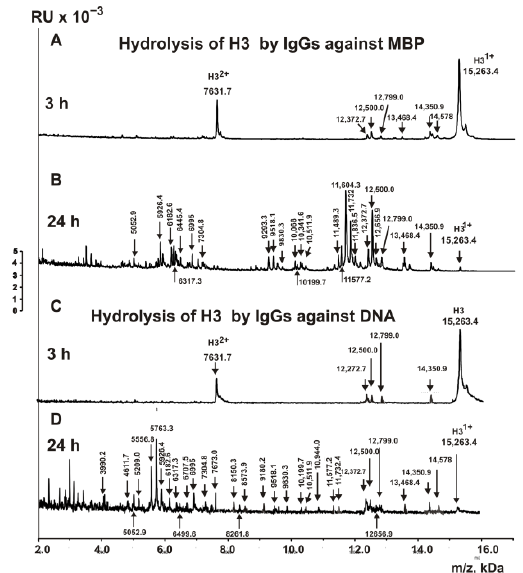
Figure 3. MALDI spectra corresponding to the H3 histone (0.8 mg/mL) over the time of hydrolysis in the presence of IgGs (0.04 mg/mL) against MBP ( A , B ) and DNA ( C , D ). All of the used antibody preparations and the molecular masses ( m / z , Da) of the products are indicated on the panels; RU — relative units.